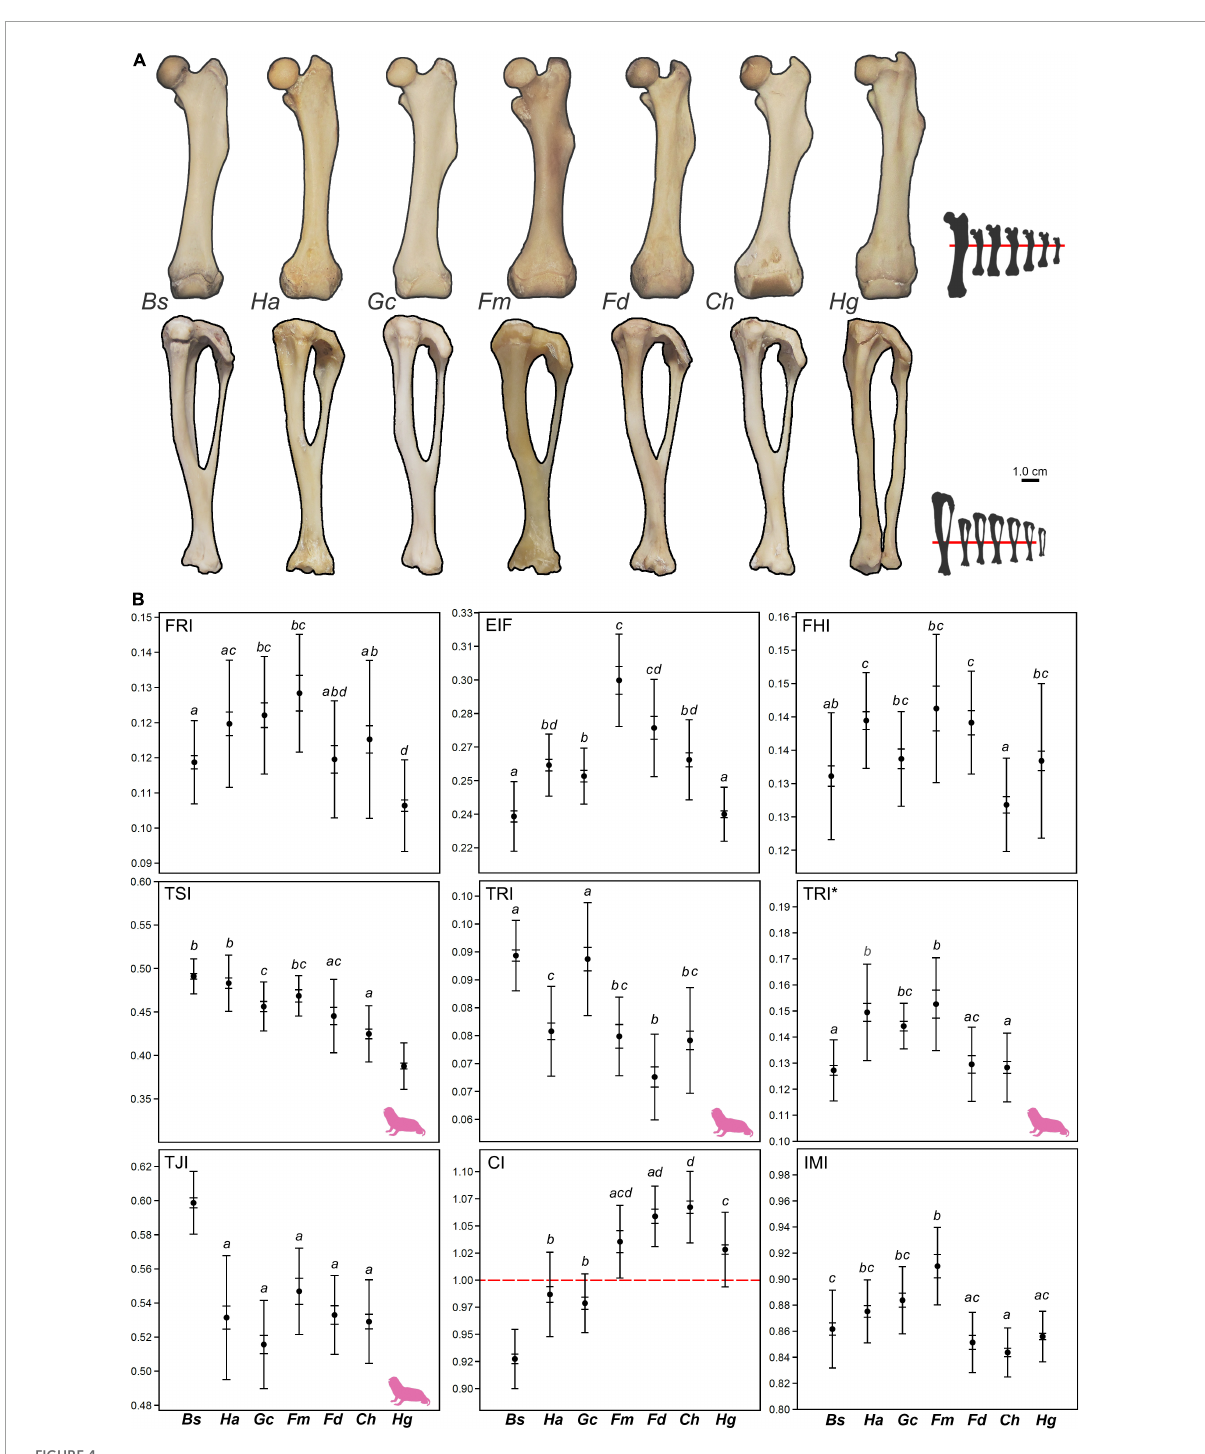
FIGURE4 Quantification of the hindlimb morphology (femur and tibia-fibula). (A) Femoral (top row) and tibio-fibular (bottom row) morphology of all species. Bones scaled to same size to emphasize differences in bone proportions. Small bones silhouettes show the real relative size of bones between species. The femora are aligned to the distal origin of the third trochanter, while the tibia-fibula are aligned to the distal tibio-fibular junction (except in Heterocephalus glaber ). (B) Whisker plots showing differences among species. The red line in the crural index (CI) indicates symmetry (= 1) between femur and tibia-fibula. Mean (central point), s.e (short whiskers) and s.d. (long whiskers). Species that share the same letter represent homogeneous subsets, as identified by post hoc (Tamhane) tests. The pink silhouette represents H. glaber and indicates the indices for which this species differs significantly from other bathyergids, as well as the indices not measured for this species (i.e. lack of morphological specialization). Taxa ordered as in Figure 3 . See abbreviation of indices in Table 2 , and of species names in Figure 3